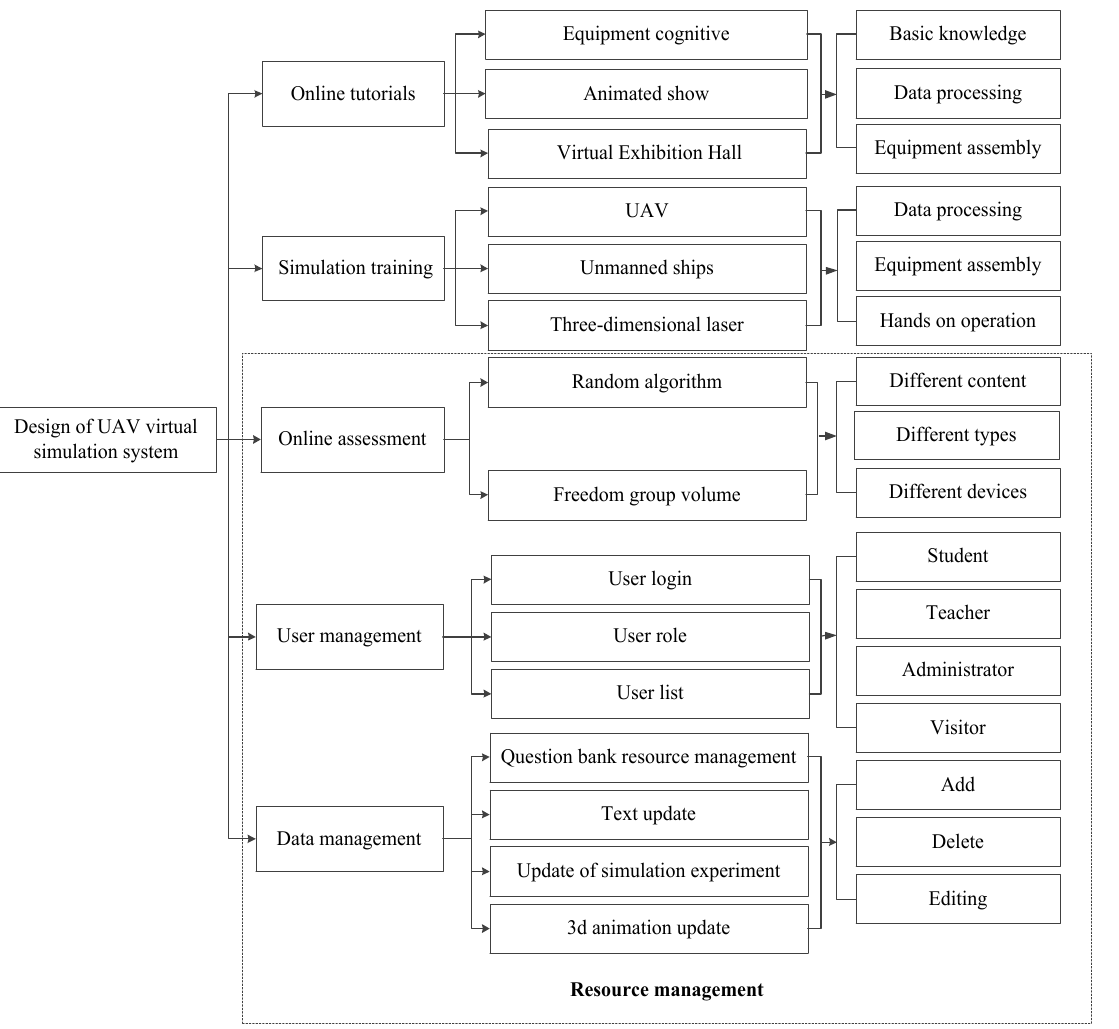
Figure 2. System overall